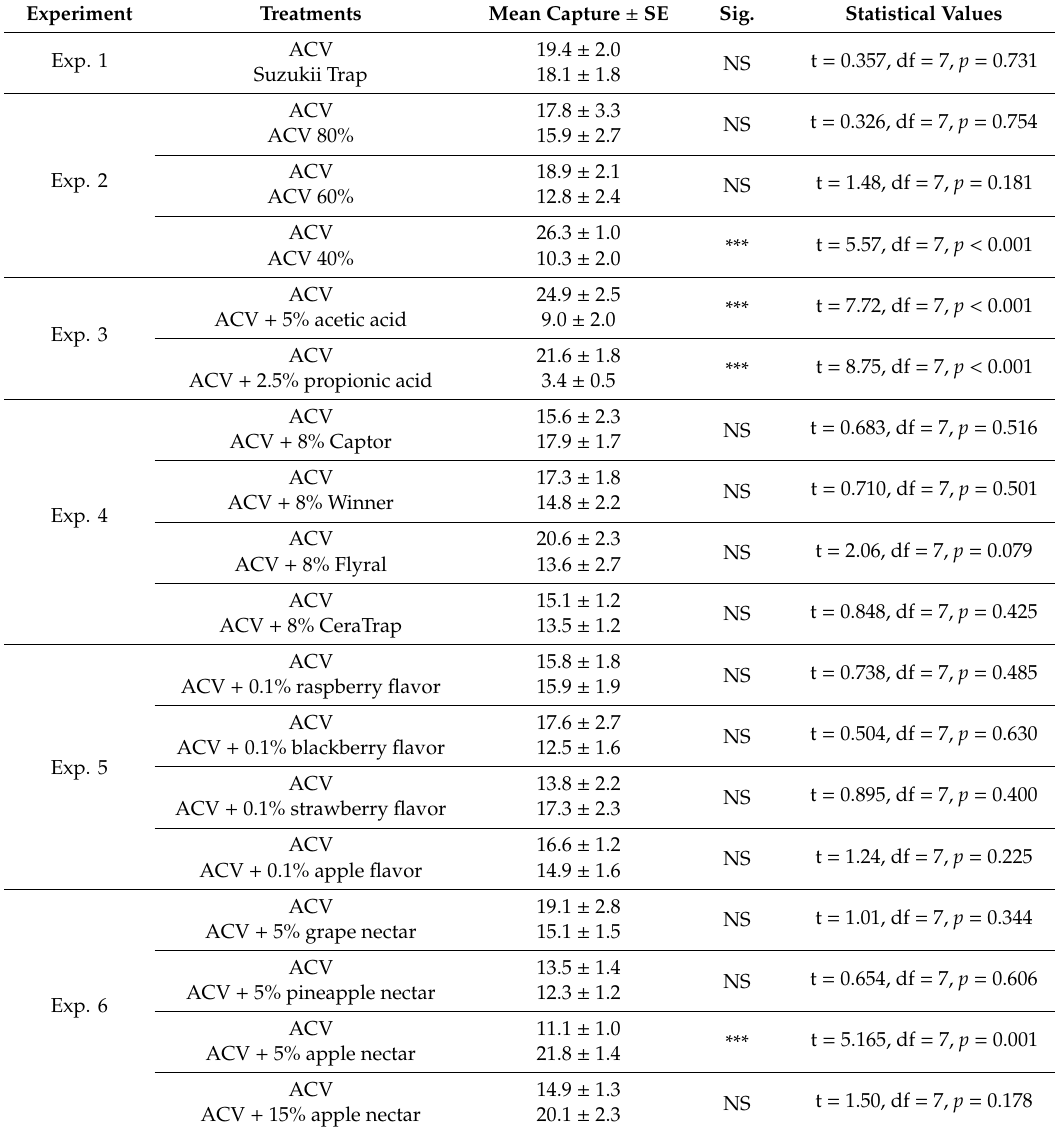
Table 1. Mean numbers of D. suzukii flies captured in the La Costeña apple cider vinegar (ACV) reference treatment used in all tests compared to captures of flies in cup traps baited with Suzukii Trap (Experiment 1) or ACV that had been modified by the addition of other substances (Experiments 2–6).